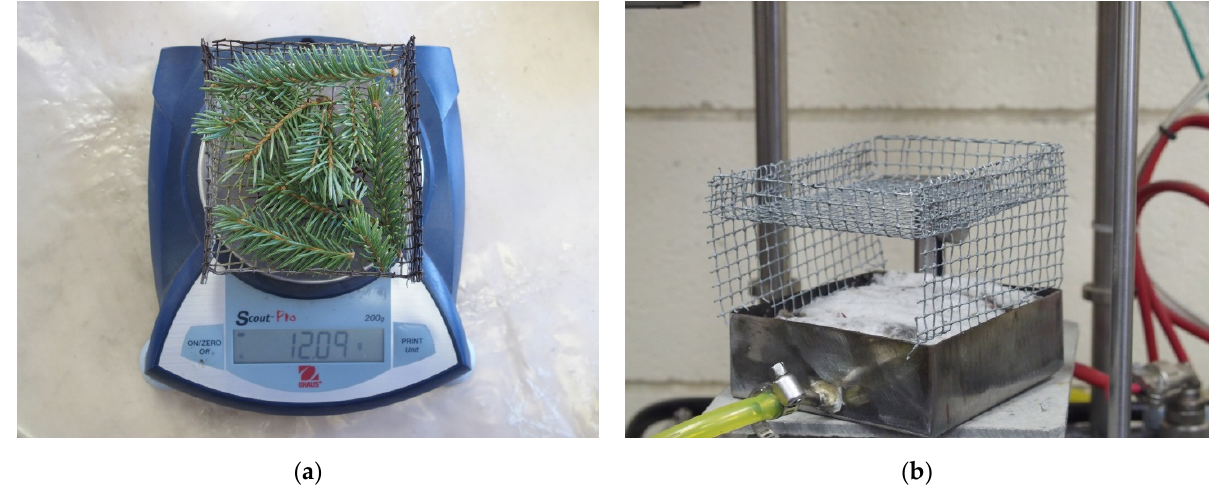
Figure 3. ( a ) Fuel sample (new shoots) in a 10 × 10 × 1 cm wire mesh sample holder placed on the weight scale. ( b ) Side view of the empty sample holder. The design of the sample holder provided a constant distance from the shoots to the ignition source and spatial uniformity (constant dimensions and controlled density) of the fuel sample.